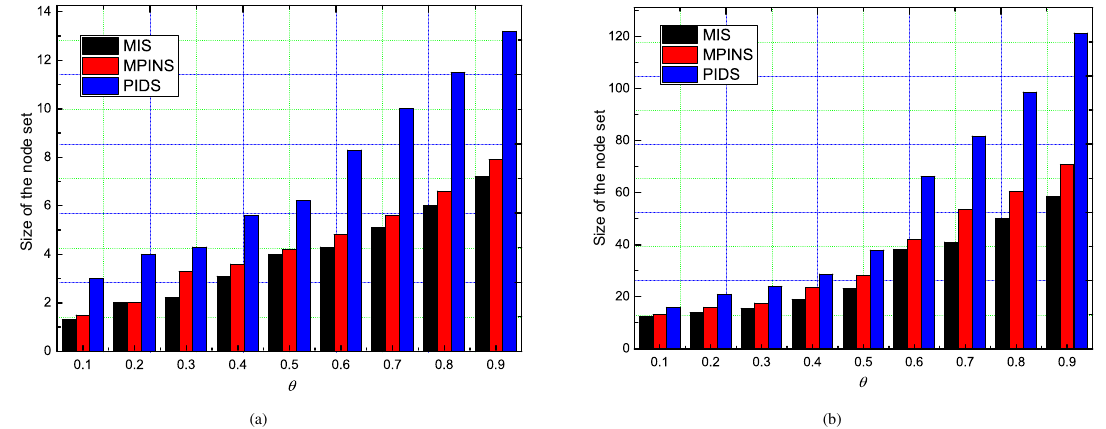
Fig. 8 Size of the node set: (a) n = 20 and p = 0.5; (b) n = 500 and p =